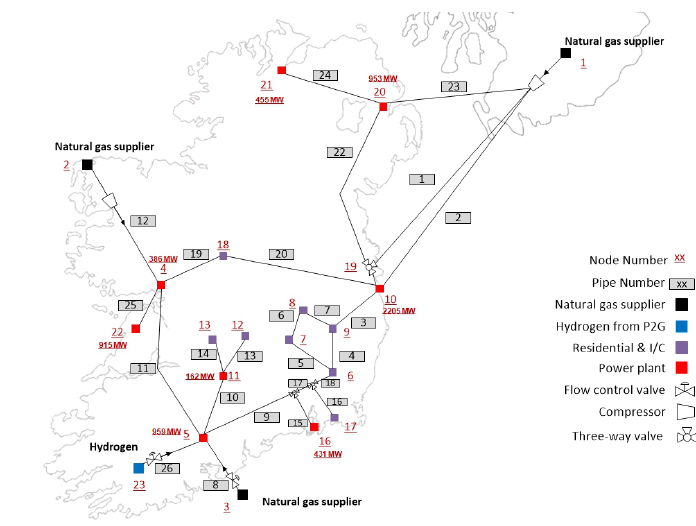
Figure 2. Simplified island of Ireland gas network with P2G interconnection